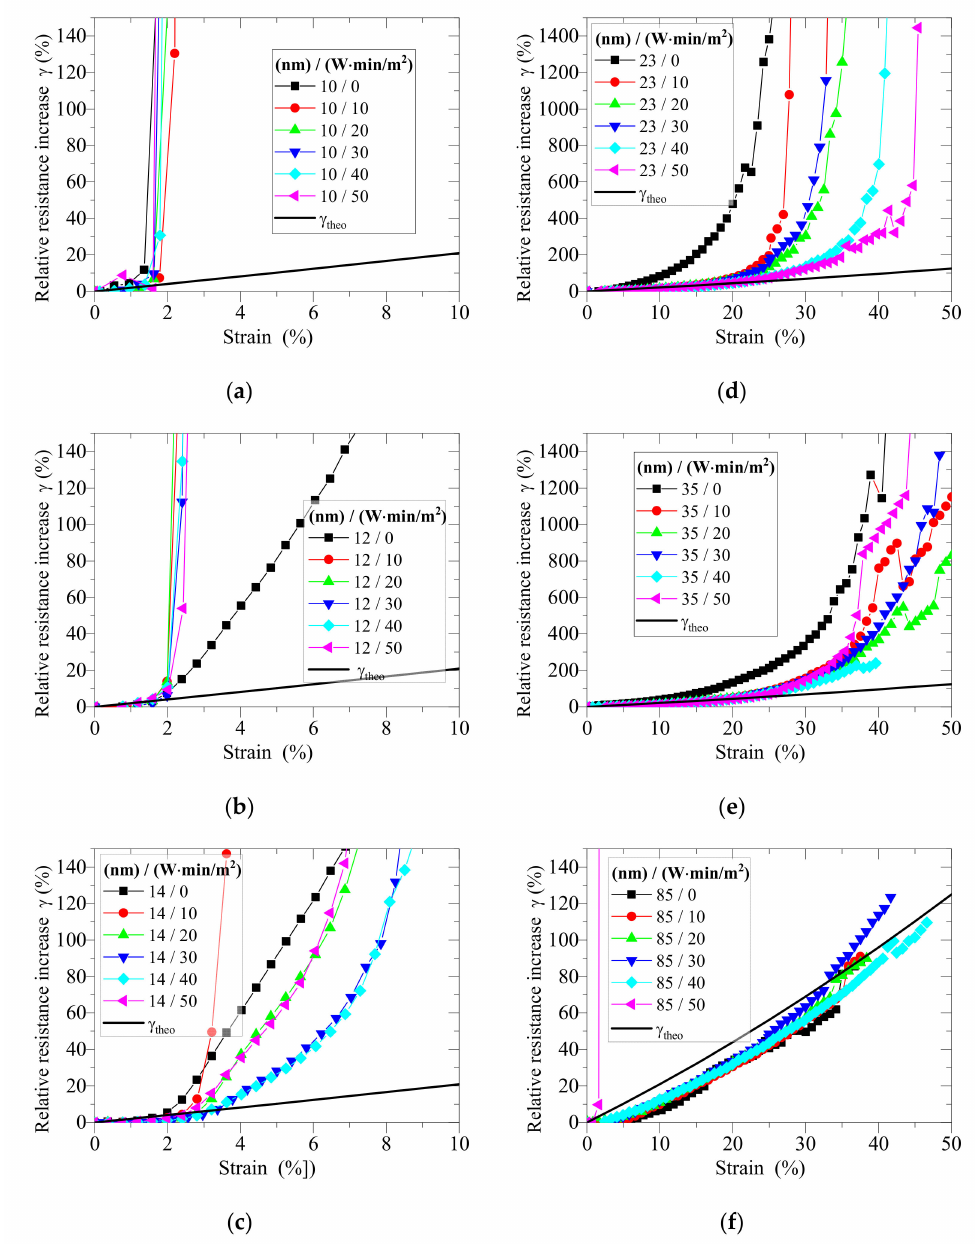
Figure 9. Increase in resistance under strain for PP films coated with aluminum layers of di ff erent thicknesses: ( a ) 10; ( b ) 12; ( c ) 14; ( d ) 23; ( e ) 35; and ( f ) 85 nm. Colored lines in each graph